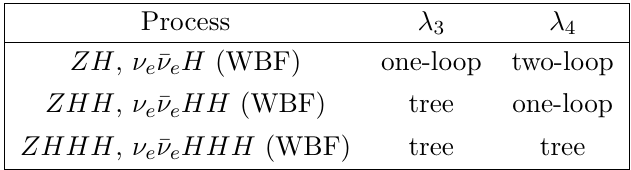
Table 1 . Processes considered in this work and the order at which the (cid:21) 3 and (cid:21) 4 dependence appears. We do not calculate two-loop e(cid:11)ects, but we do calculate one-loop e(cid:11)ects for both single and double Higgs